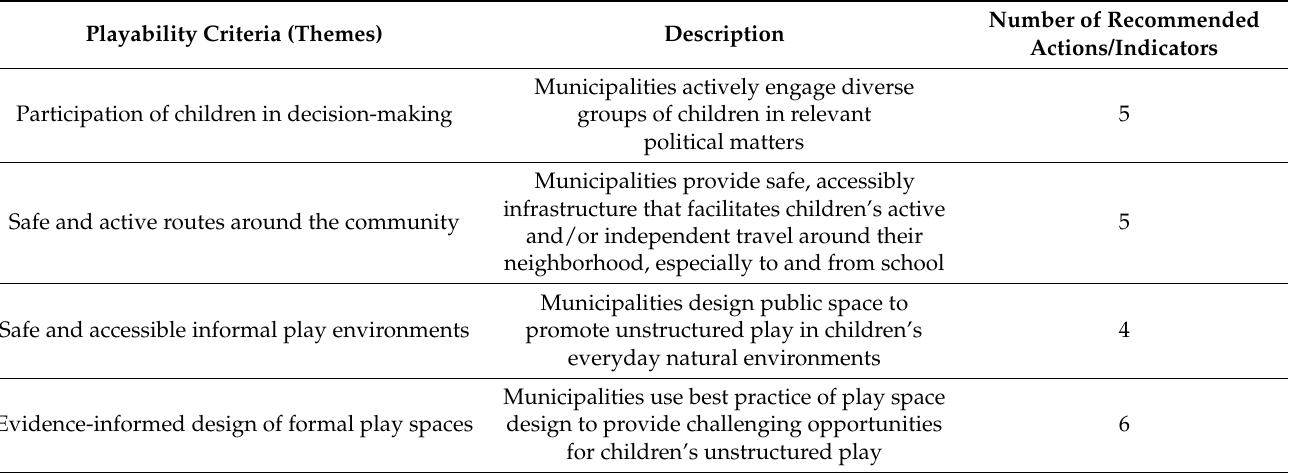
Table 1. Framework of Action for a Play-Friendly